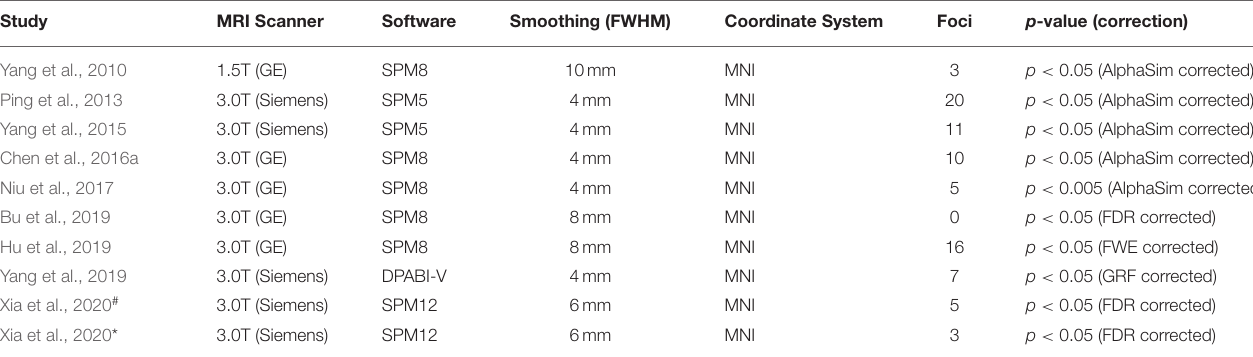
TABLE 2 | Technical details of ReHo studies on OCD in the current